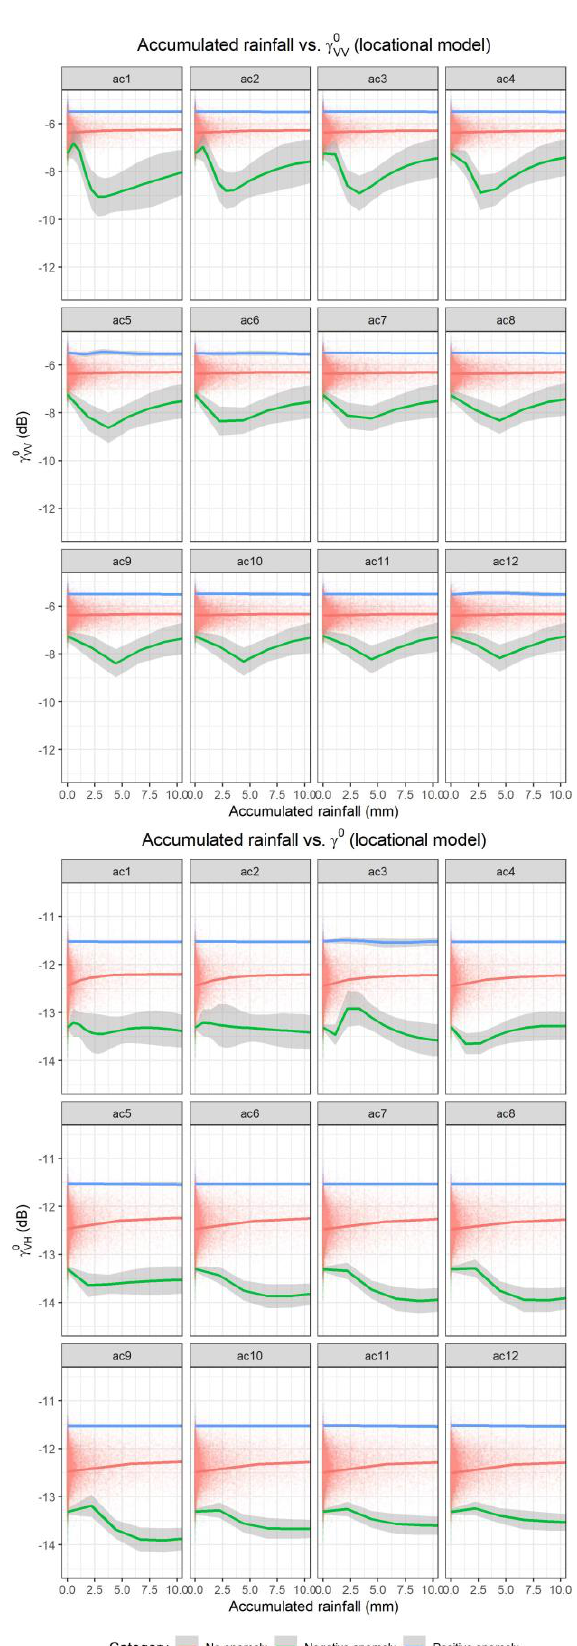
Figure 3: VV and VH γ 0 values vs. accumulated rainfall. Ac[i] refers to the accumulated rain [i] hours before the acquisition of the SAR data. Continuous lines are GAM models. Grey shades represent model 95% confidence interval.